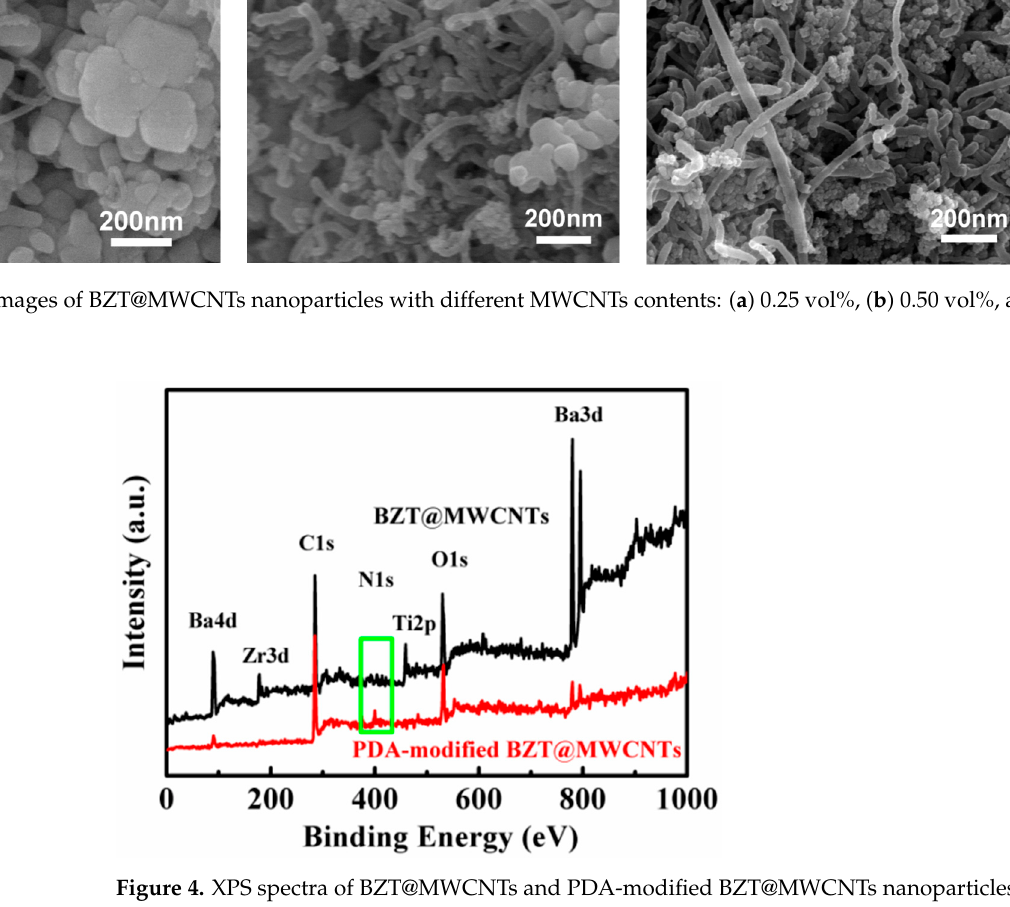
Figure 3. SEM images of BZT@MWCNTs nanoparticles with different MWCNTs contents: ( a ) 0.25 vol%, ( b ) 0.50 vol%, and ( c ) 1.00 vol%.